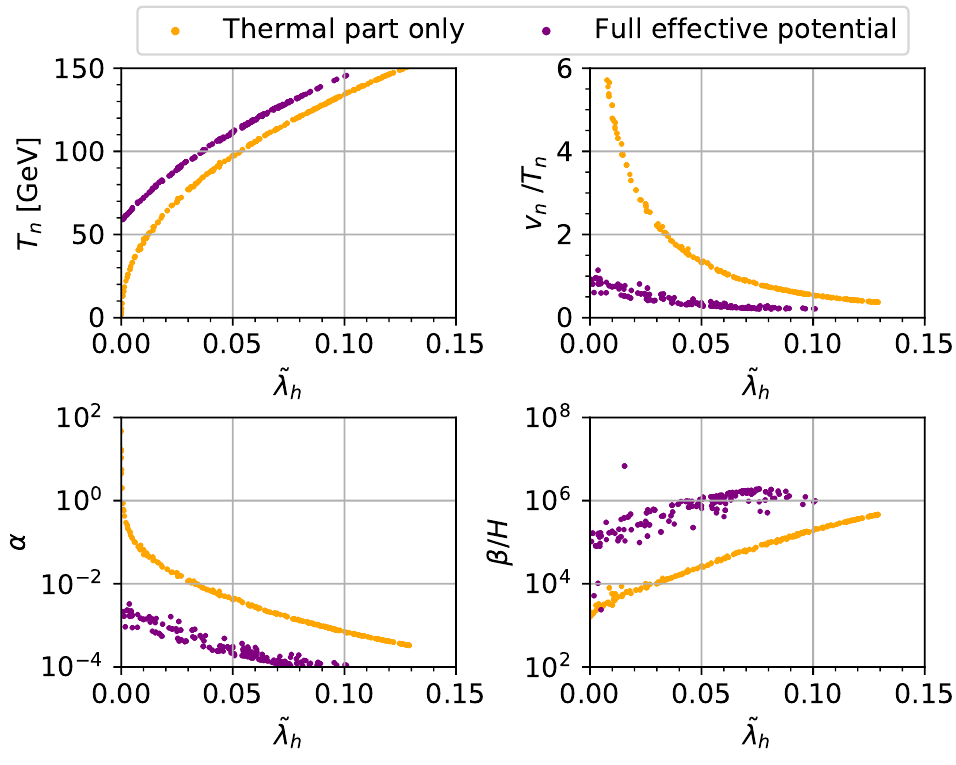
Figure 2 . The phase transition parameters T n , v n ˜ λ h for the thermally-corrected and full forms of the effective